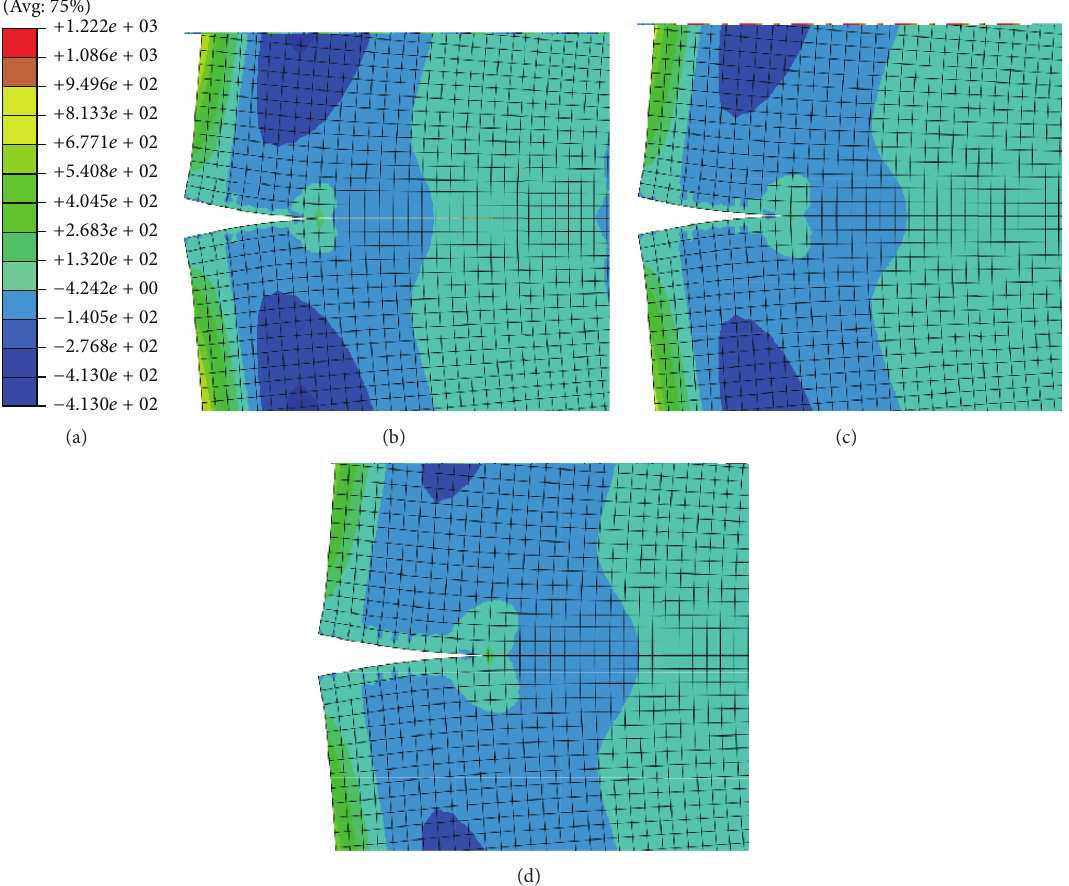
Figure 11: Contour plots of transient stress 𝜎 𝑦𝑦 at different moments of time: (a) scale level, (b) 𝜏 = 0.1 (c) 𝜏 = 0.5 , and (d) 𝜏 = 1.0